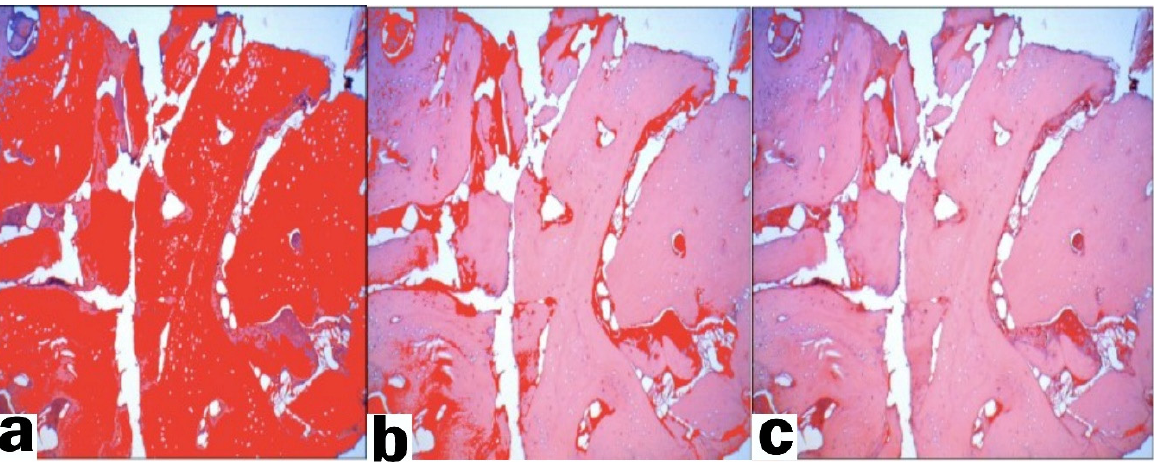
Figure 5 . Digital pictures of the microscopic samples: ( a ) newly formed bone area; ( b ) connective tissue area; ( c ) residual graft particles area.